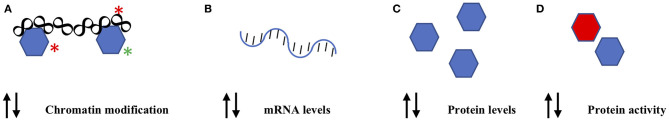
Molecular mechanisms that may contribute to pituitary population restructuring. Pituitary cell populations may utilize multiple molecular mechanisms for restructuring including (A) chromatin remodeling (B) gene transcriptional control (C) control of mRNA translation to protein and (D) control of protein function. The double arrows indicate the potential for both activating (positive) and inhibitory (negative) effects upon these molecular mechanisms. See text for details and relevant references.